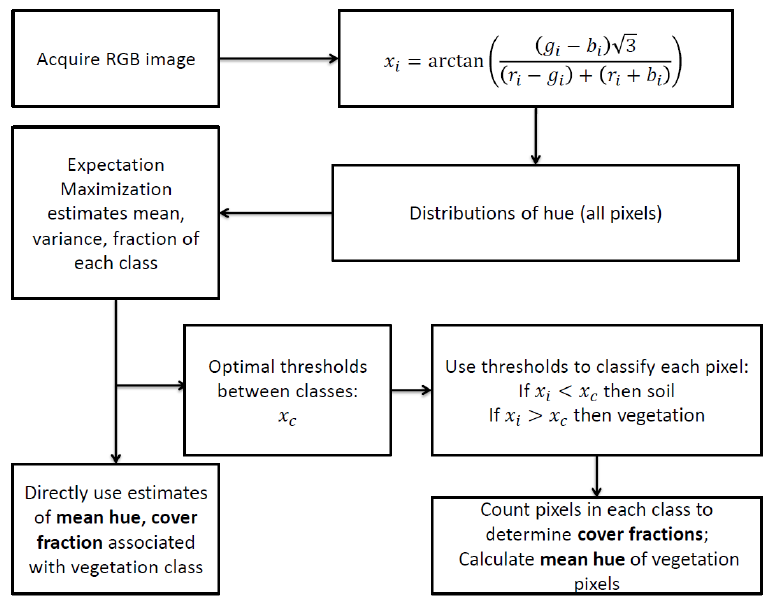
Figure 2. Flow chart of image processing algorithms for Fuji